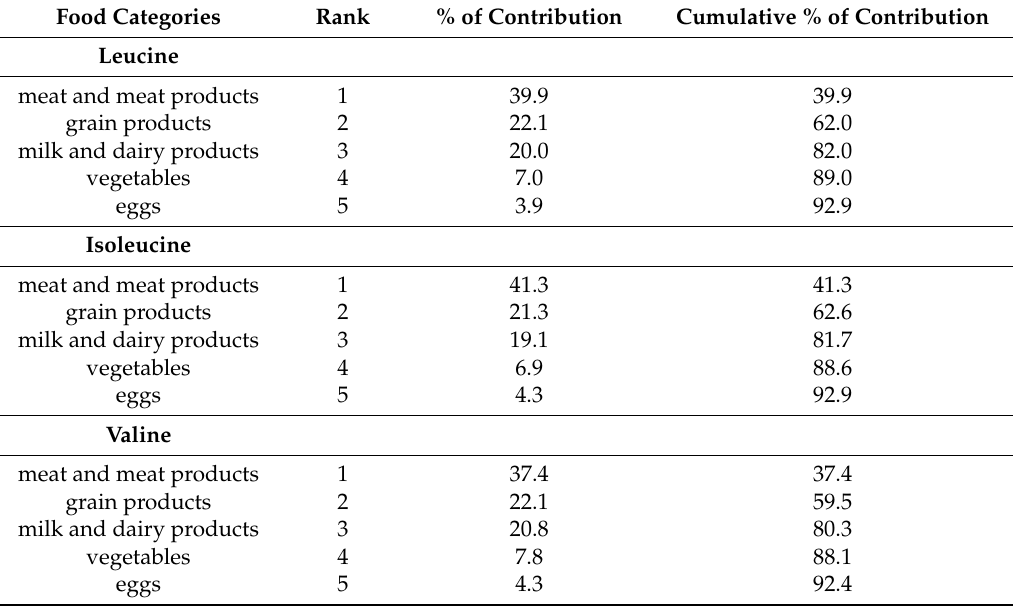
Table 3. Main food category sources of leucine, isoleucine and valine contribution to the average Polish